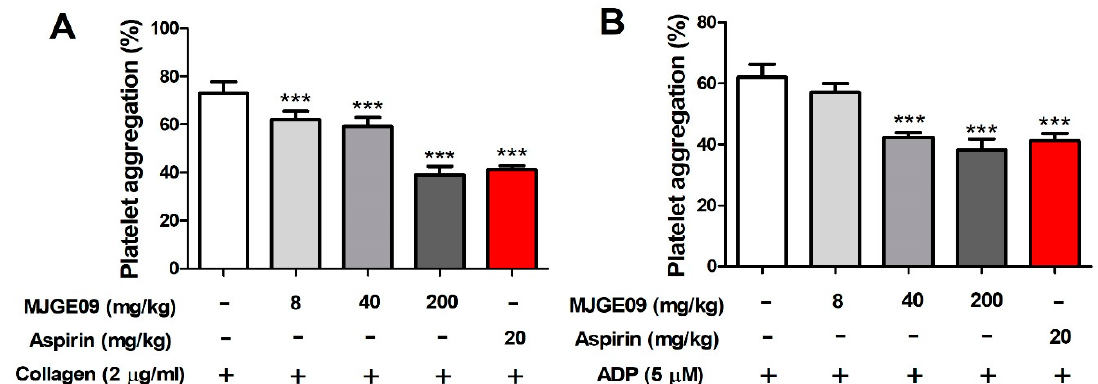
Figure 5. Inhibitory effects of orally administered MJGE09 (8, 40, and 200 mg/mL) on ex vivo platelet aggregation. Platelets from orally administered rats were isolated and aggregation was induced with collagen (2 µg/mL) ( A ) or ADP (5 µM) ( B ). Data represent the mean ± S.E.M ( n = 6). Statistical significance was set at *** p < 0.001 when compared with the control group.